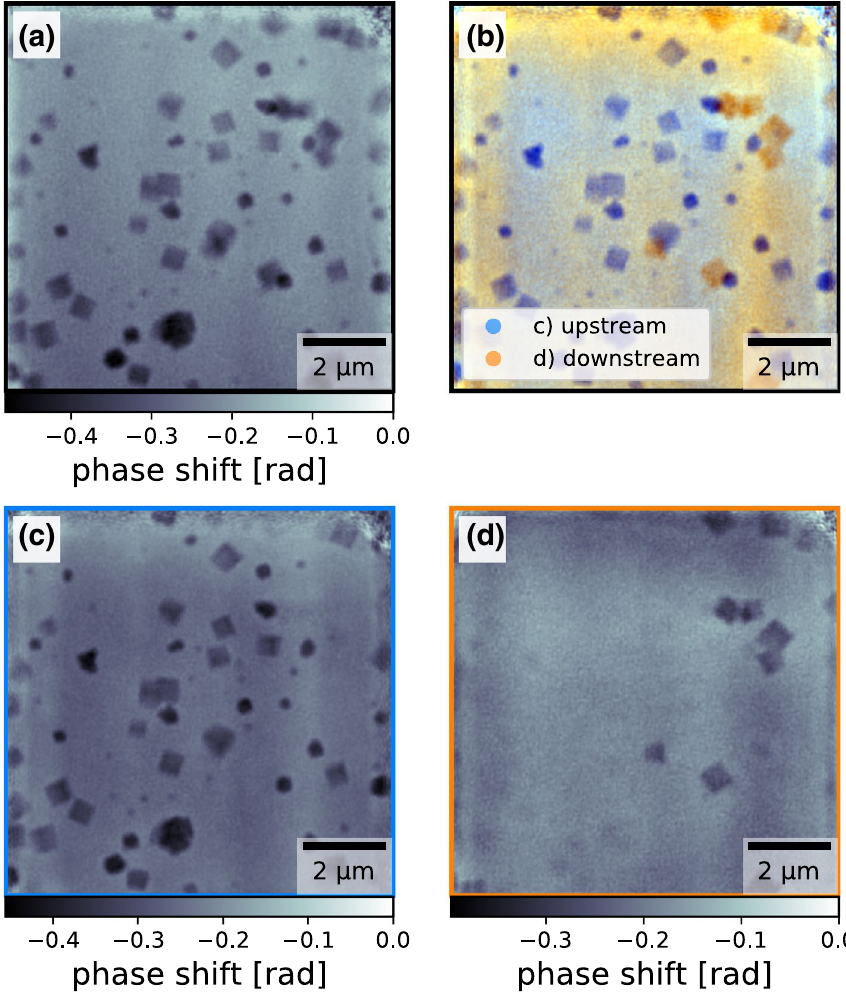
Figure 6. Phase reconstructions of the experiment using the chemical reactor: ( a ) ptychographically reconstructed object phase using the single slice ePIE algorithm ( b ) colored overlay of the upstream object slice (blue, c ) and the downstream object slice (orange, d ), reconstructed using the multi slice 3PIE algorithm. The figure was created using matplotlib 35 (version 3.1.3 36